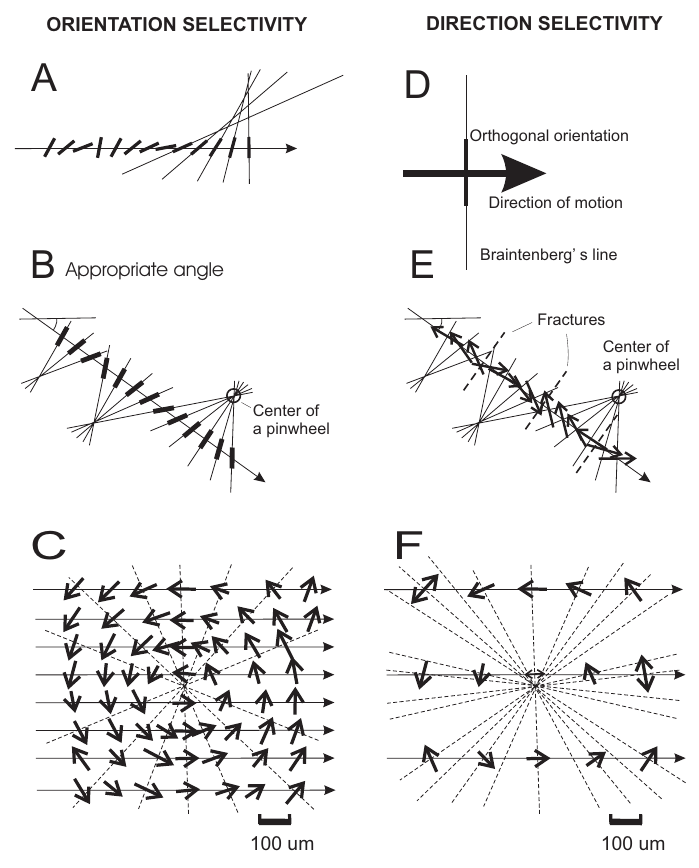
Fig. 1 – The method of Braitenberg (for details see